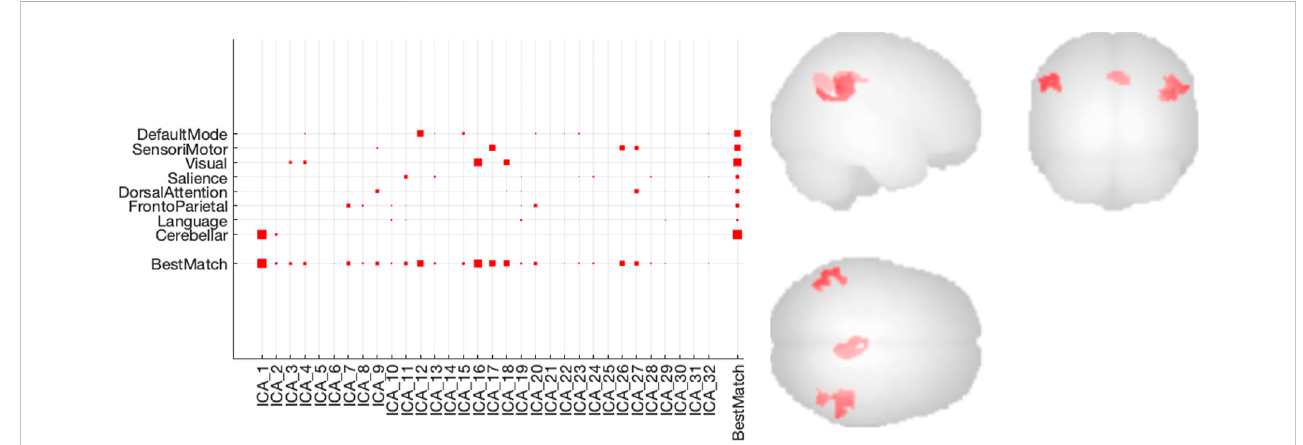
FIGURE 5 Connectivity results of group-ICA analysis of the rs-fMRI data (left) Degree of spatial match of the different independent components with prede fi ned functional networks (right) Increased functional connectivity within the Default Mode Network (DMN) using a seed based connectivity analysis with IC12 (DMN) nodes as seed